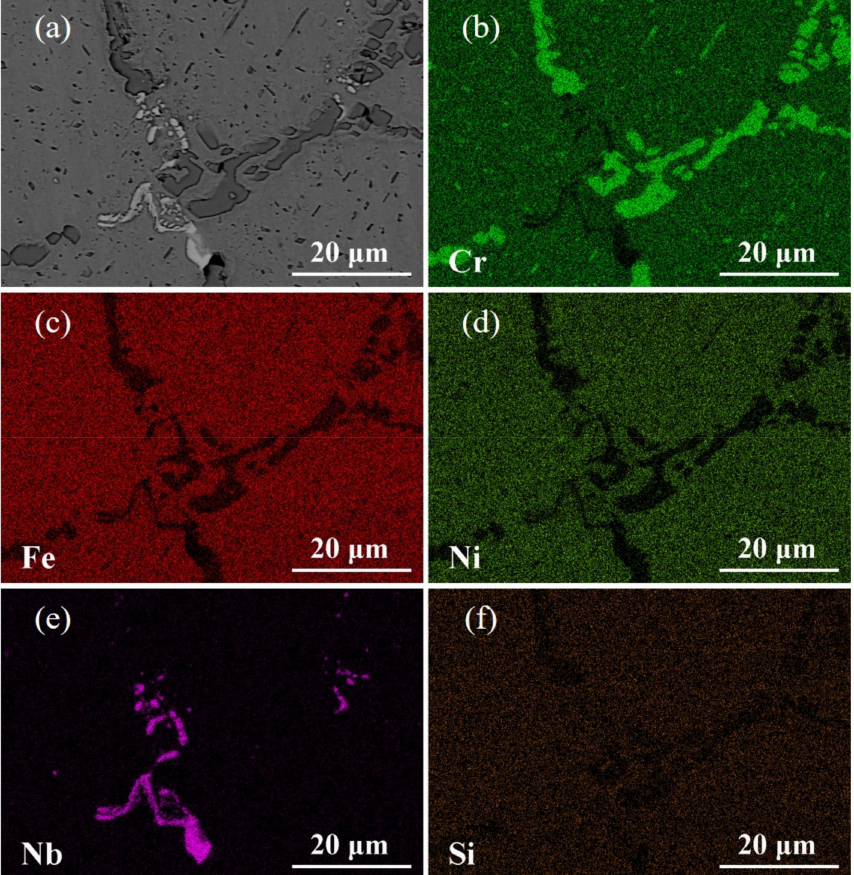
Figure 6. Precipitations in the sample after aging at 990 ◦ C for 2000 h detected using SEM elemental mapping: ( a ) SEM image, ( b ) Cr, ( c ) Fe, ( d ) Ni, ( e ) Nb and ( f ) Si elements.